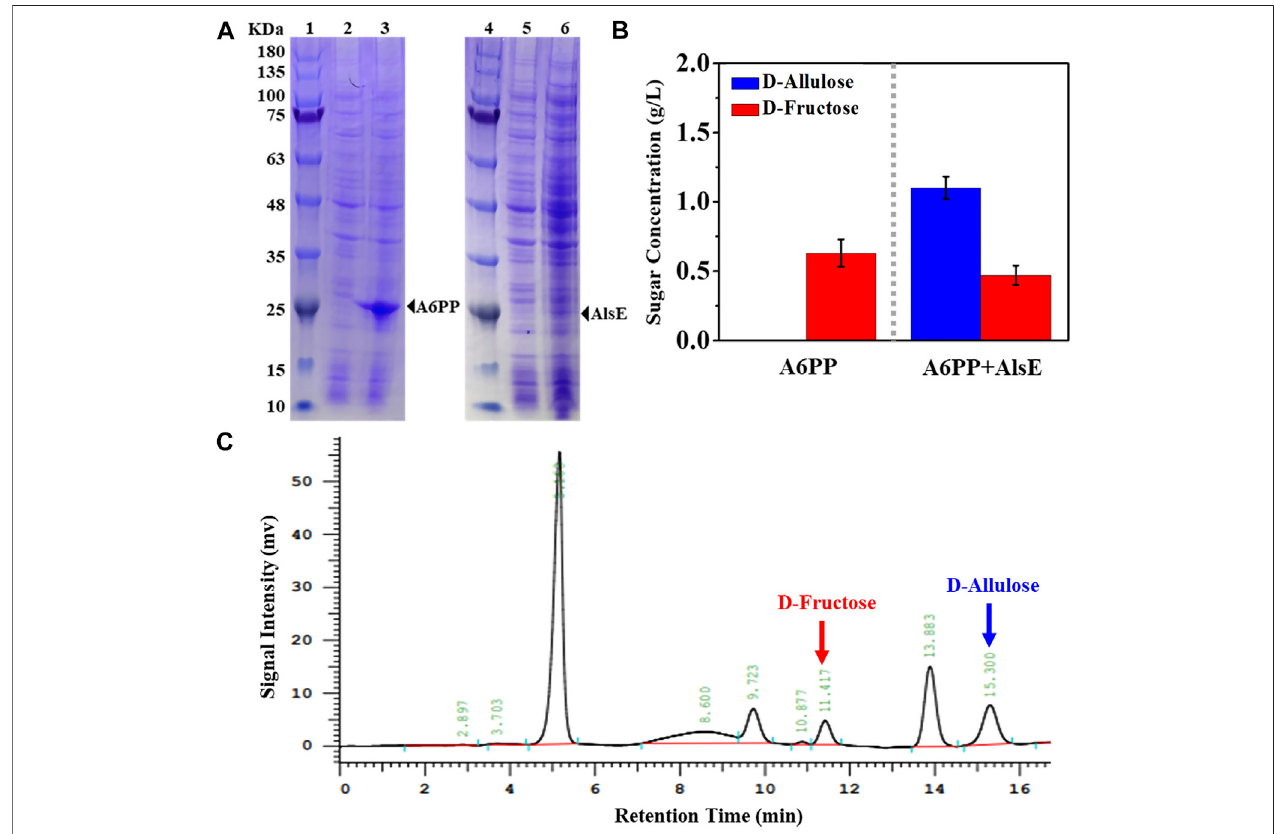
FIGURE 2 | Expression and enzyme assay of A6PP and AlsE. (A) SDS-PAGE analysis. Marker (lane 1 and 4), E. coli ( control ) (lane 2 and 5), E. coli ( a6PP ) (lane 3), E.coli ( alsE )(lane6). (B) ConversionofD-fructosetoD-alluloseusingcrudeA6PPoramixtureofcrudeA6PPandAlsE.ThereactionwascarriedoutinTris-HClbuffer(pH 7.5, 50 mM) containing 2.60 g/L fructose-6-phosphate at 37 ° C for 30 min. Error bars, SD , n = 3 . (C) HPLC analysis for con fi rming the generation of D-allulose by use of A6PP and AlsE